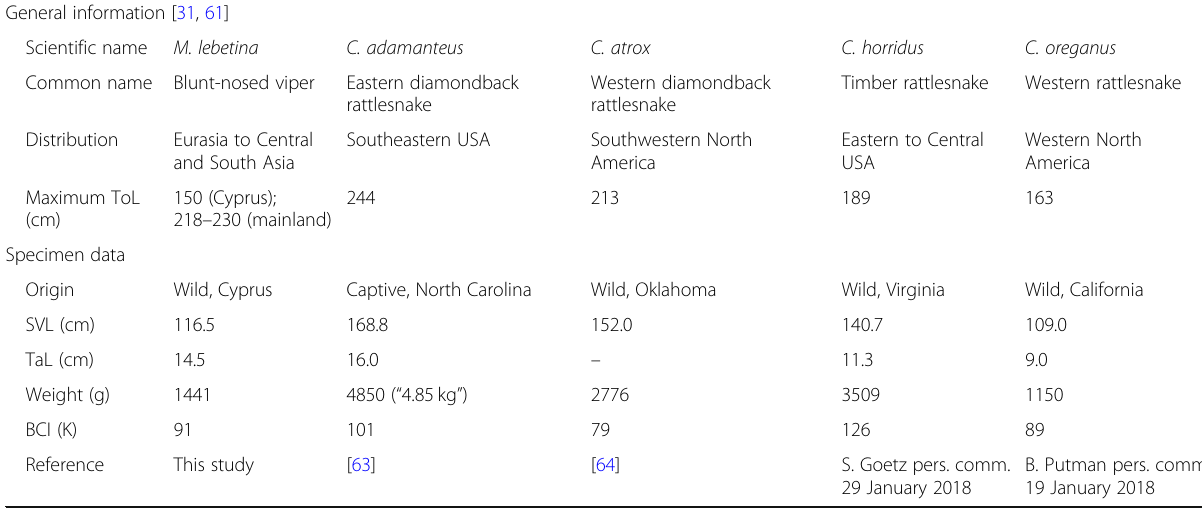
Table 7 Snout-vent length, weight and body condition index (BCI) of M. l. lebetina compared to large North American rattlesnake species ( Crotalus spp.,